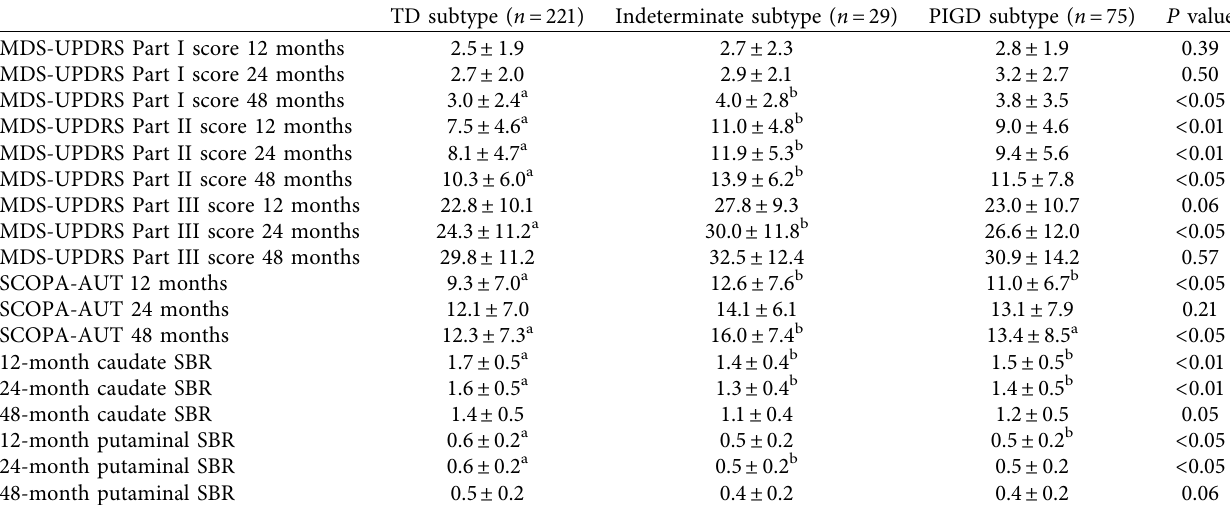
Table 3: Aggravation of MDS-UPDRS scores, SCOPA-AUT, and putaminal SBRs during the follow-up of each subtype.